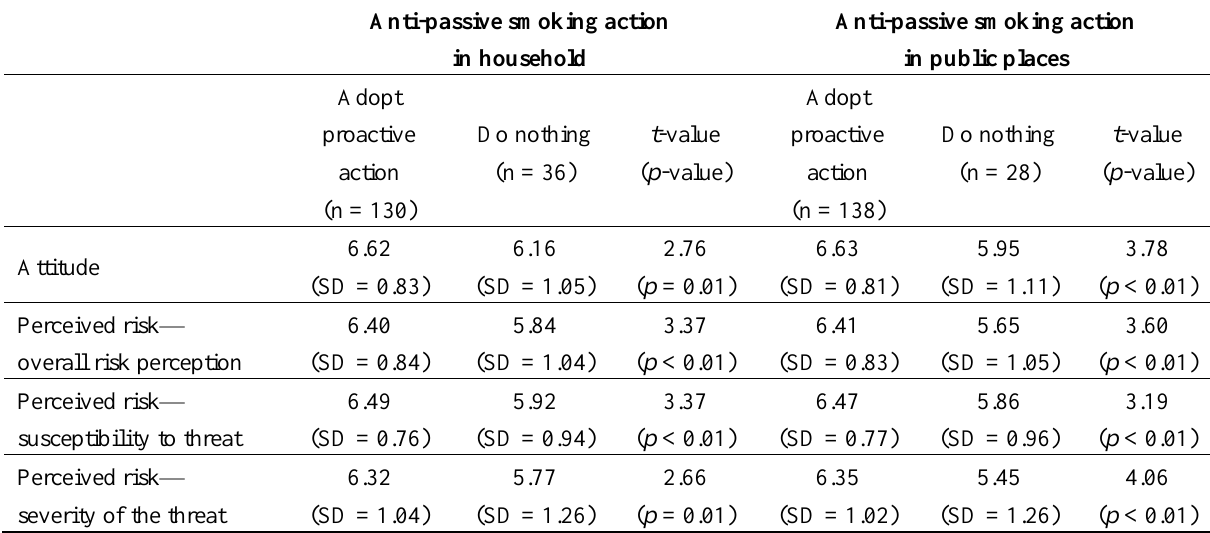
Anti-passive smoking action in public places